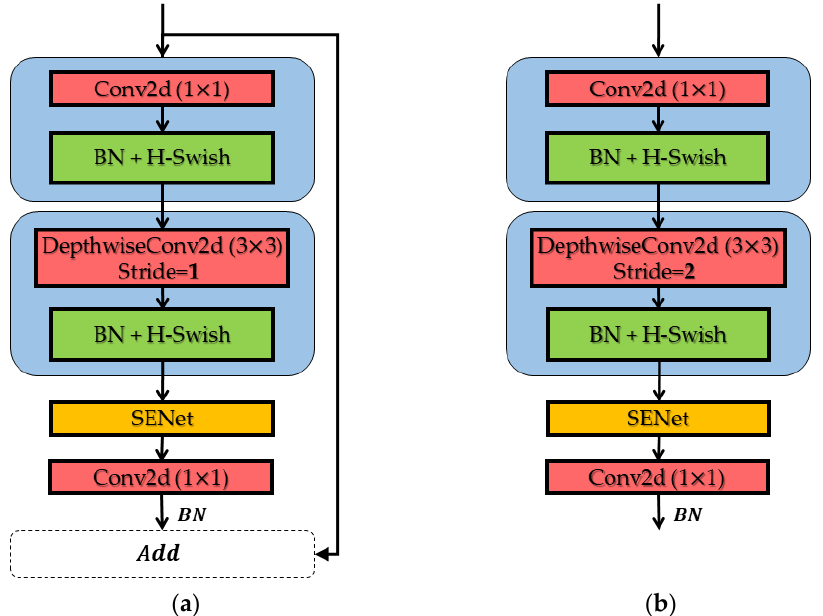
Figure 3. The structure of two backbone network modules: ( a ) Stride 1 and ( b ) Stride 2, respectively.